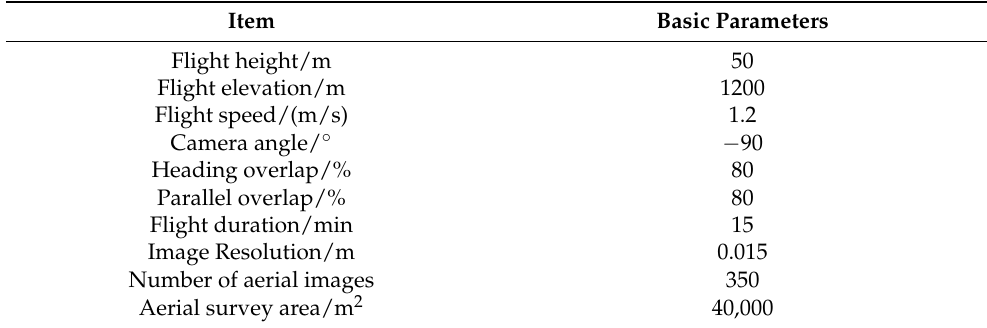
Table 1. UAV flight parameters.